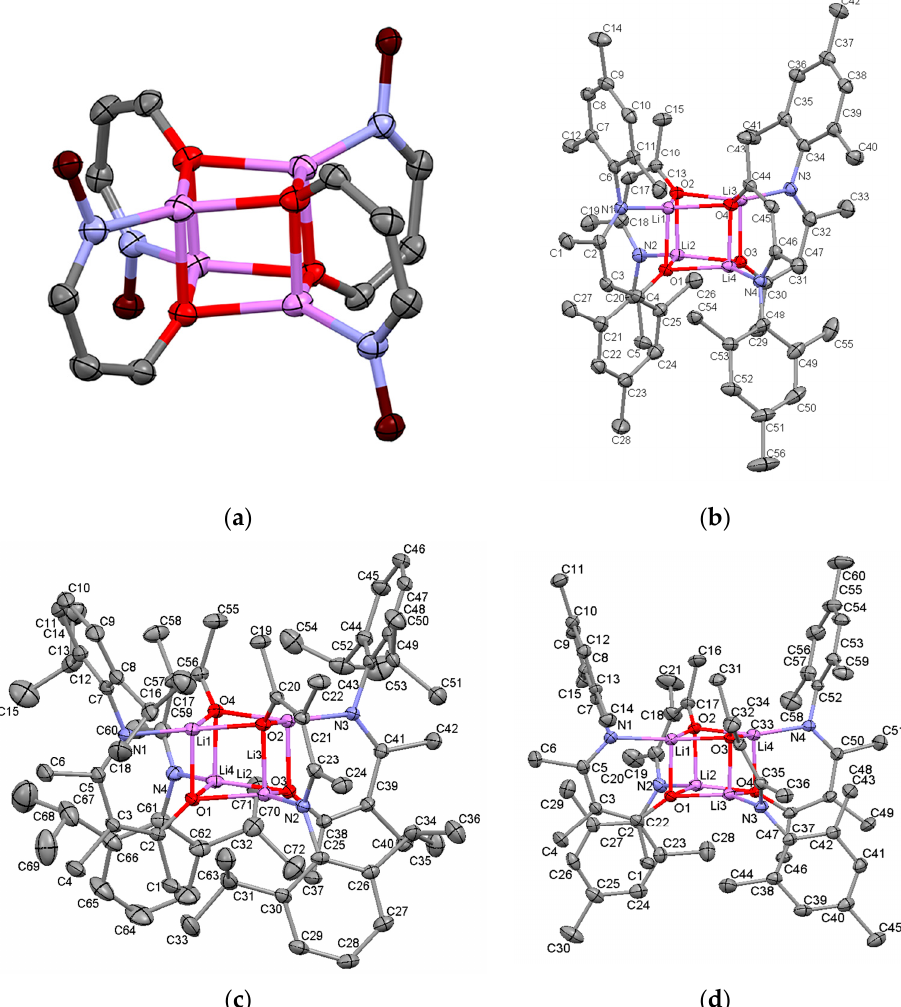
Figure 3. Displacement ellipsoids plots (40% probability) of the tetrameric molecular structures of cuboidal Li 4 O 4 ketoiminate clusters as found in their crystal structures: ( a ) common cuboidal core with ipso carbon of the aromatic groups coloured brown; ( b ) cluster 3b ; ( c ) cluster 3c ; and ( d ) cluster 3d . The atom numbering schemes are shown. H atoms on C have been omitted to enhance visualization of the clusters. A disordered, uncoordinated toluene molecule present in the lattice of 3b has been omitted and solvent presumed to be heptane was removed from the structure of 3c using the “SQUEEZE” method.